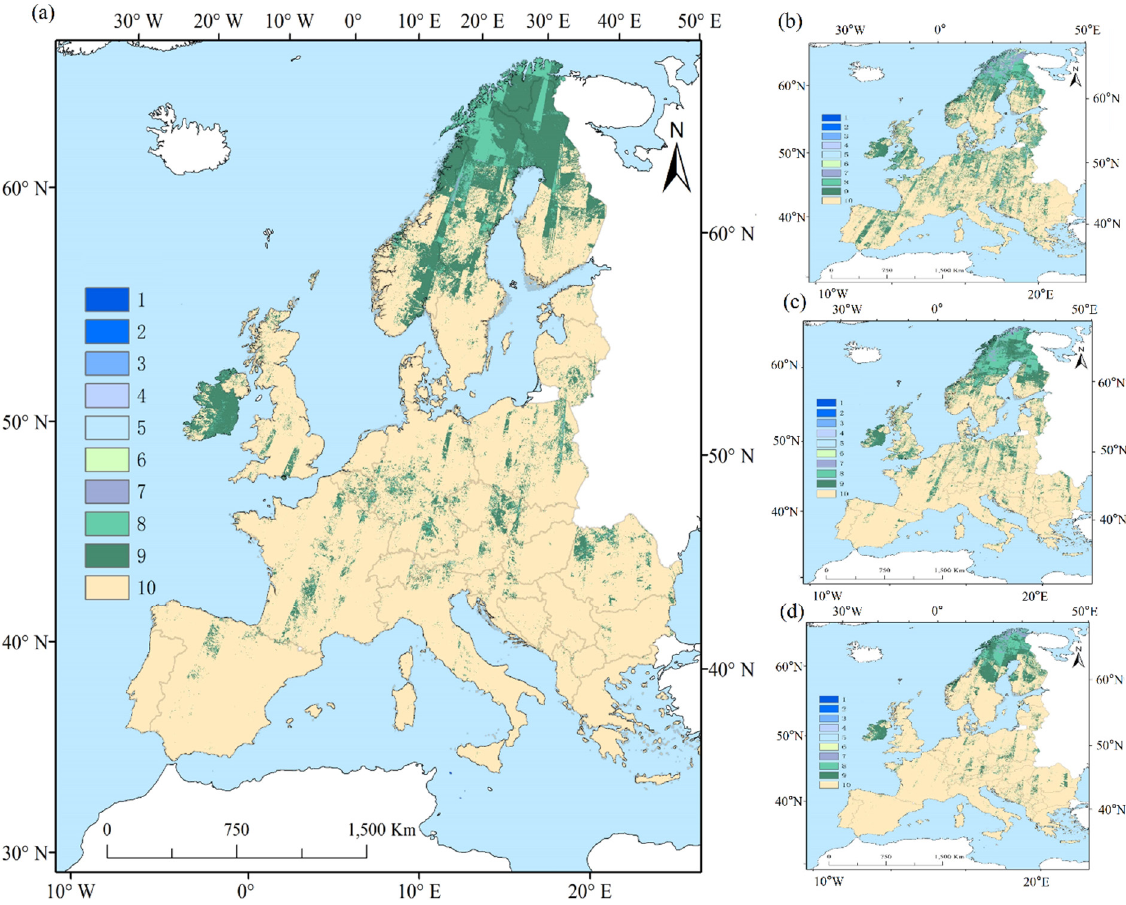
Figure 2. Number of months with good (cloud-free) observations in Europe, derived from the monthly maximum composite NDVI from October to the following July, 2016–2019. ( a – d ) show 2018, 2016, 2017, and 2019, respectively.